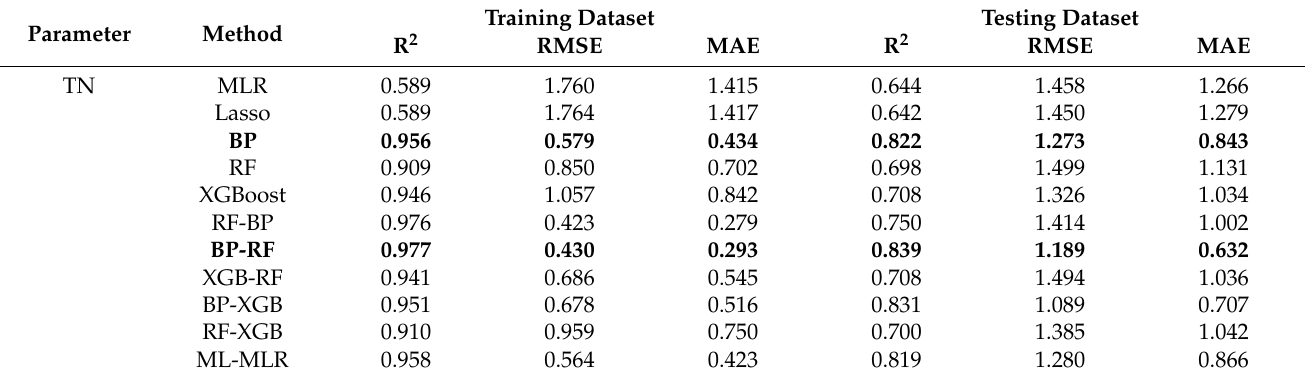
Table 8. Comparison of the performance of single ML models and stacked ML models for TN.